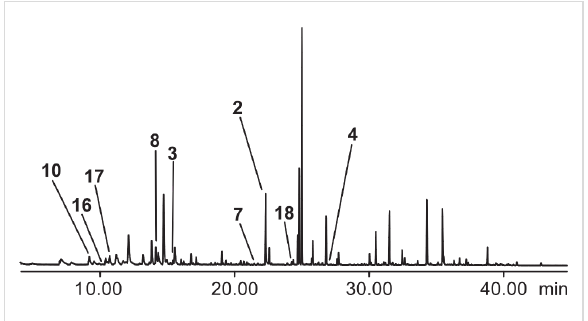
Figure 2: Total ion chromatogram of a headspace extract of a culture of Mycobacterium tuberculosis strain 2, grown on a 7H11 solid medium. Nonlabeled peaks originate from the nutrient